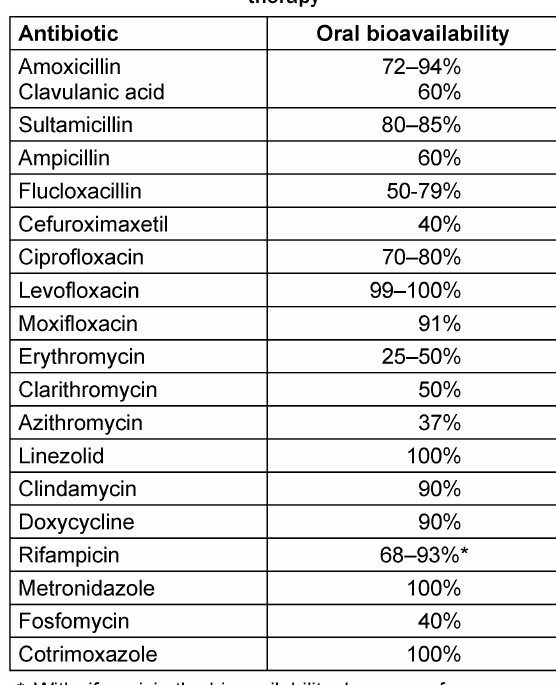
Table 5: Oral bioavailability of antibiotics for sequential